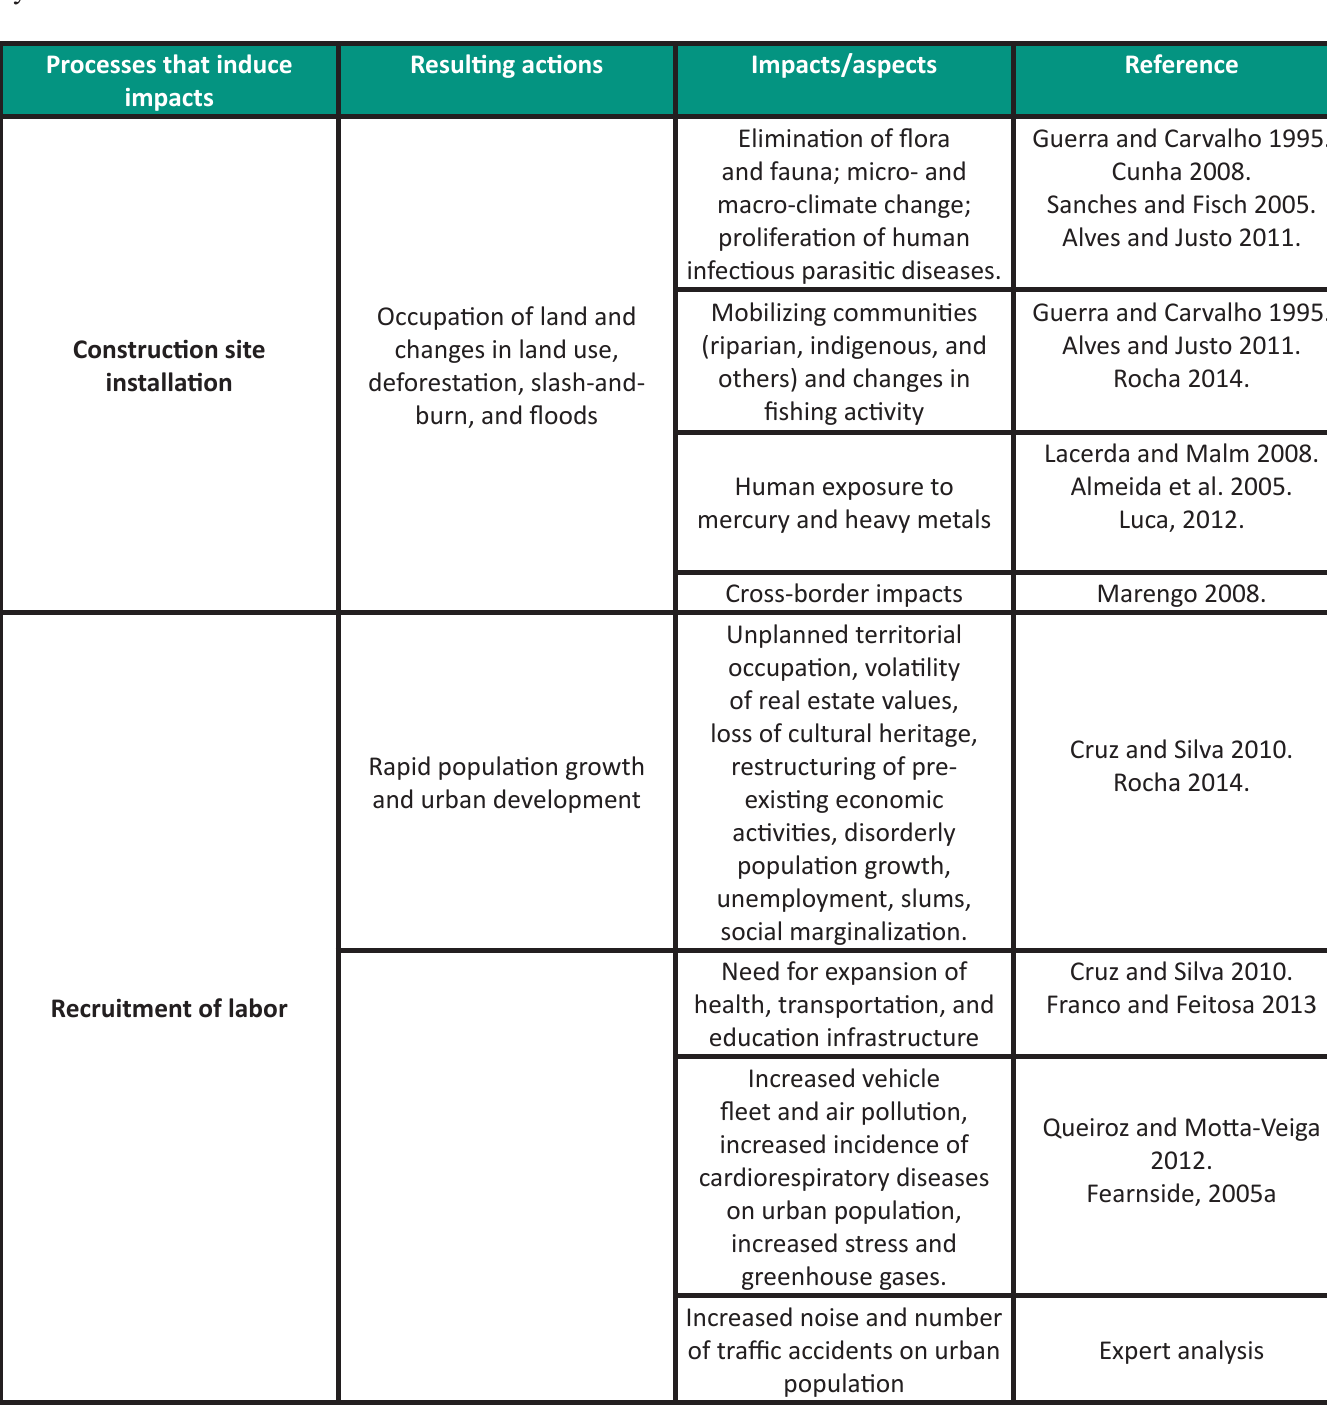
Table 1. Processes that induce impacts and actions and impacts/aspects resulting from the construction of hydroelectric dams in